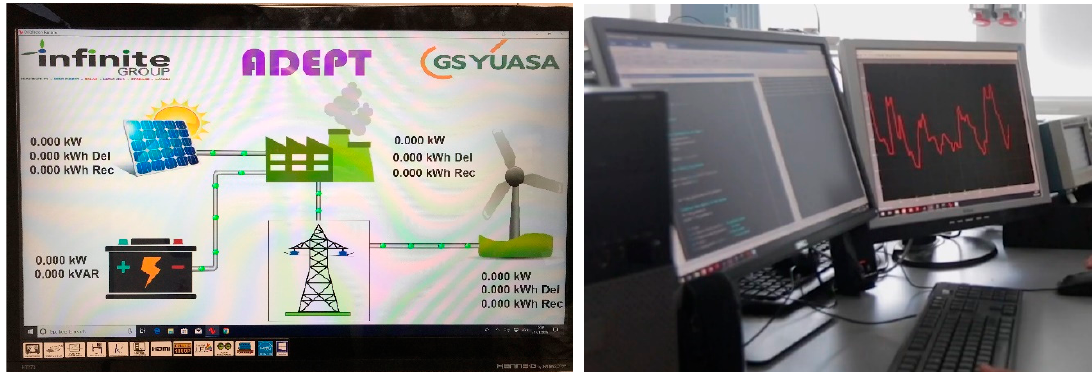
Figure 8. Remote monitoring and control of the ADEPT system (cyber part).